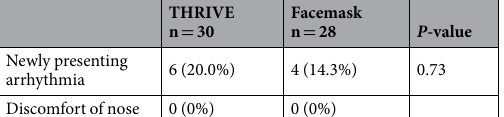
An increase in the duration of apnoea was observed in the THRIVE group. Improvement of the duration of apnoea might be caused by increased apnoeic oxygenation in the THRIVE group compared with the face- mask group. By delivering heated and humidified oxygen with a flow rate greater than the patient’s demand for oxygen, THRIVE has been proven to provide a small amount of continuous positive airway pressure (CPAP) 20 . Continuous insufflation-induced CPAP opens the upper airways and decreases the pulmonary shunt, which is postulated to explain the mechanism underlying the increased apnoeic oxygenation provided by THRIVE 18 . To